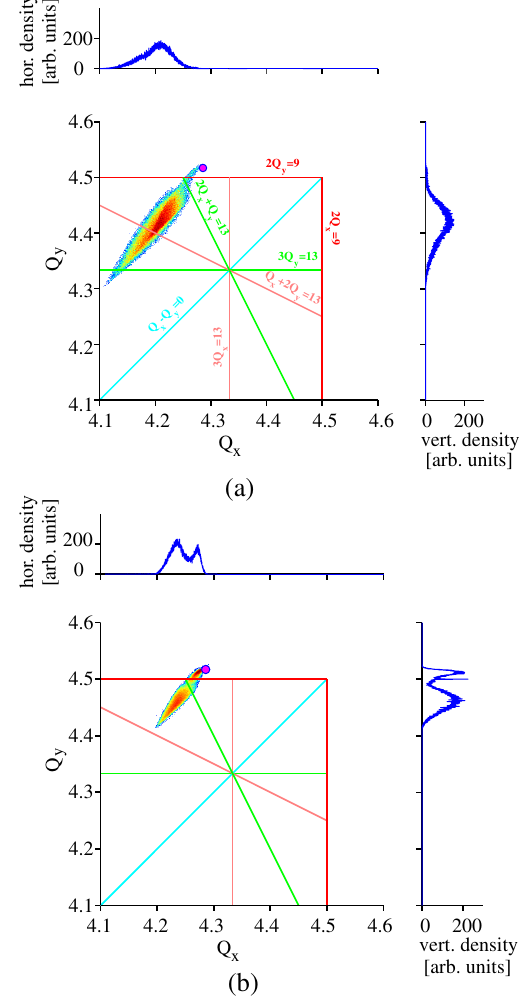
FIG. 14. The PTC-Orbit simulated tune footprint (averaged over 1500 turns) at 485 ms (a) and 565 ms (b), with particle density color code (blue, low density — red, high density). In (b), note the narrow peak on the 2 Q y ¼ 9